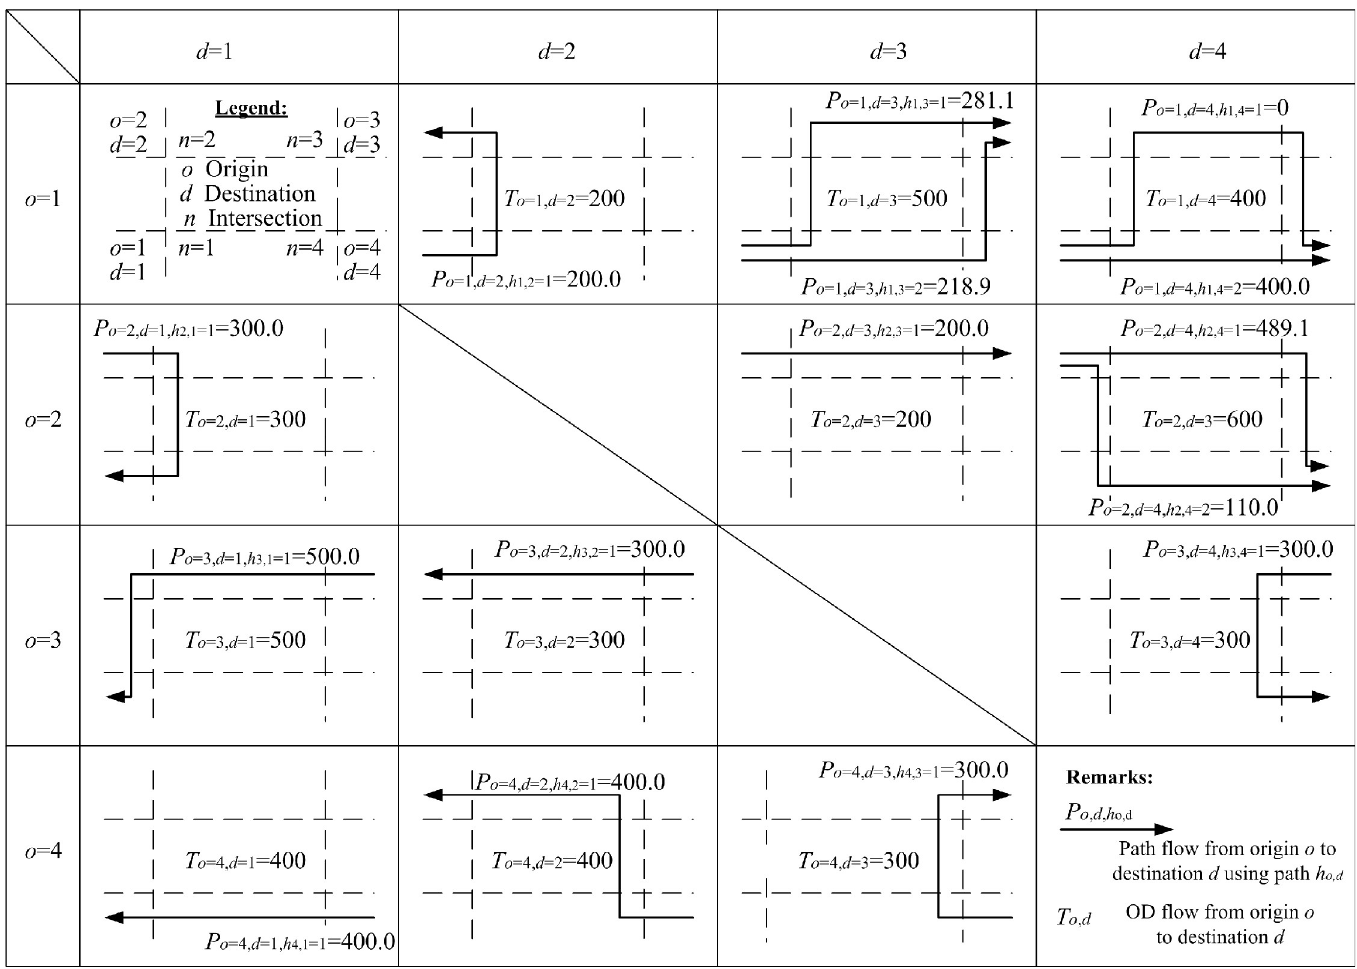
Fig 11. Optimized path flow details for the case study network matching the given OD demand flows (in pcu/h) with W (maximized).